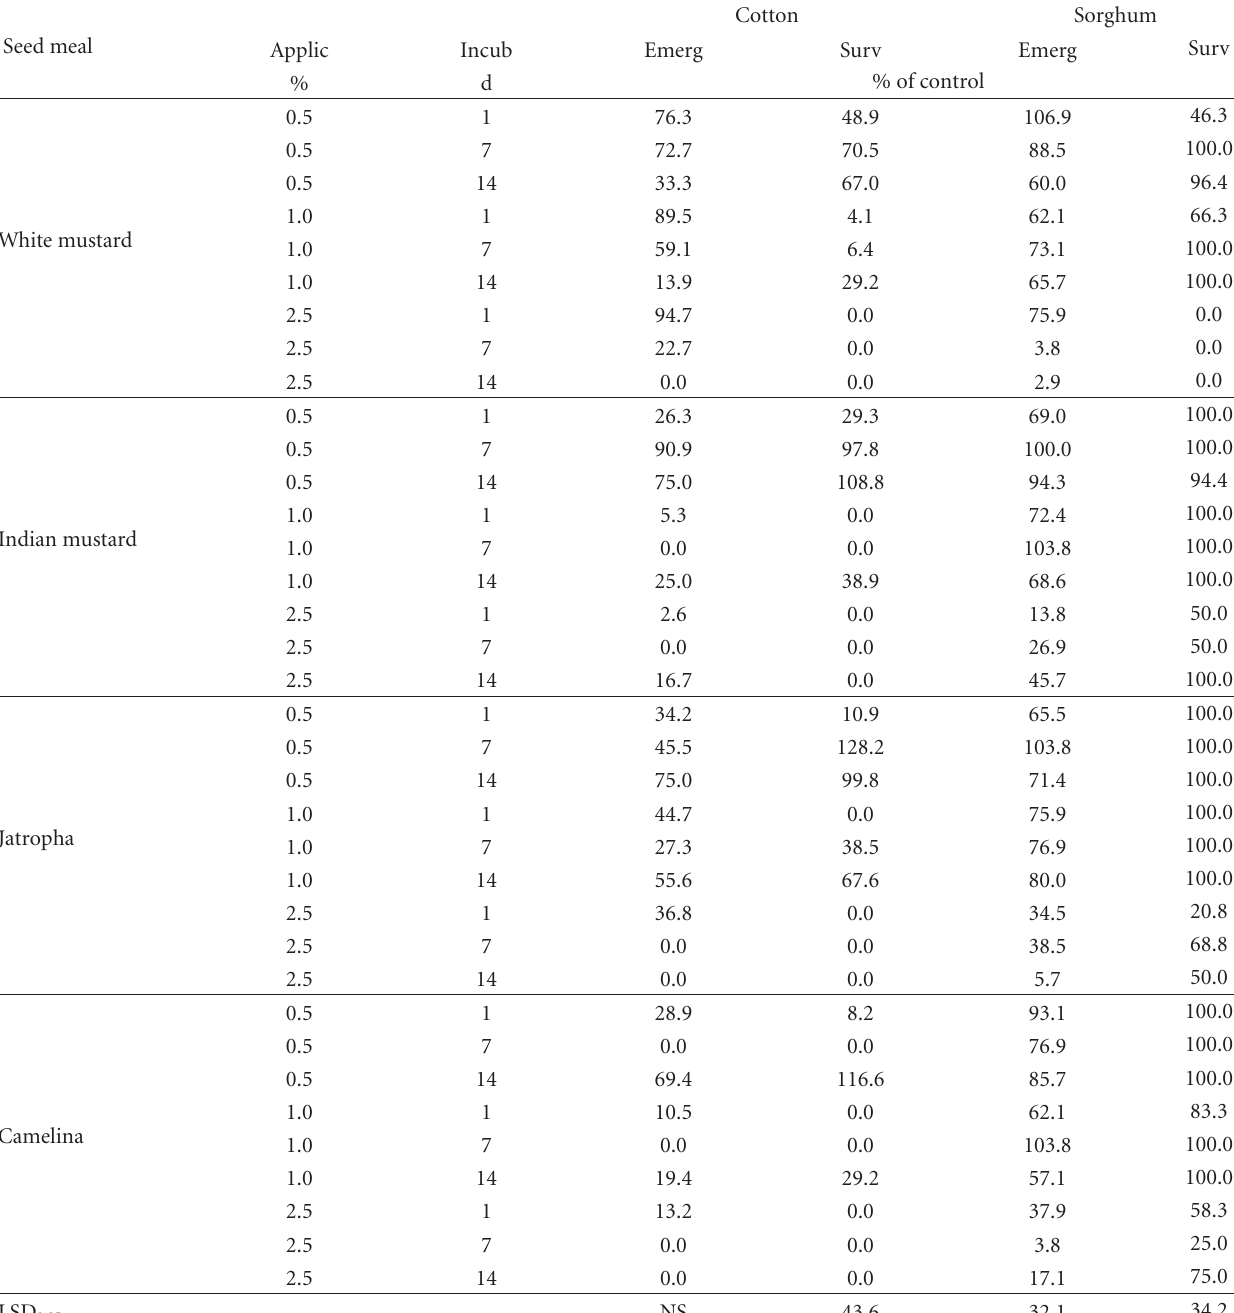
Table 4: Three-way interaction of “seed meal source, application rate (applic), and incubation time (incub)” on cotton and sorghum emergence (emerg) and survival (surv). Incubation refers to the length of time in days after SM was added to soil and prior to seeding. Data are the means (four replications) within crop species ( n =